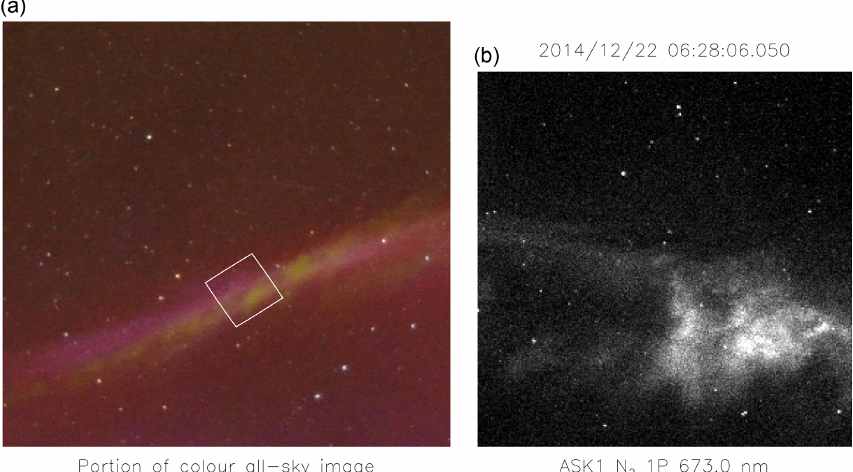
Figure 4. A portion of the colour all-sky image (a) corresponding to the ASK image in N 2 1P recorded at 06:28:06.05UT during event 2 (b) . The location of the ASK field of view is indicated in the all-sky image as a white box. The ASK image is selected from the centre of the all-sky camera exposure